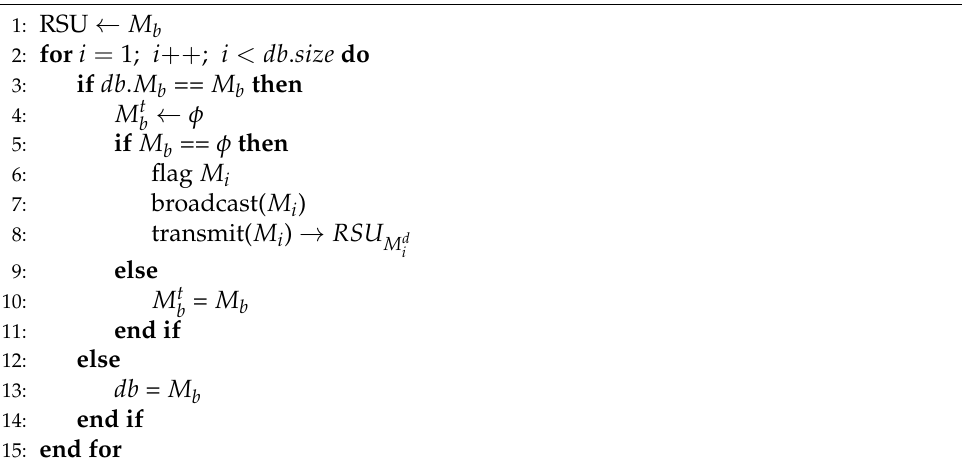
Algorithm 1 Anomaly detection at